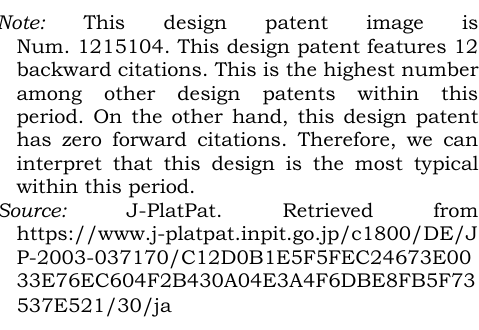
Figure 1. Example of design